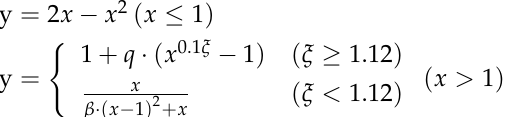
where x = ε , y = σ , ε , and σ are the strain and stress of the concrete, and ε 0 , σ 0 , q , β are ε 0 σ 0 calculation parameters.